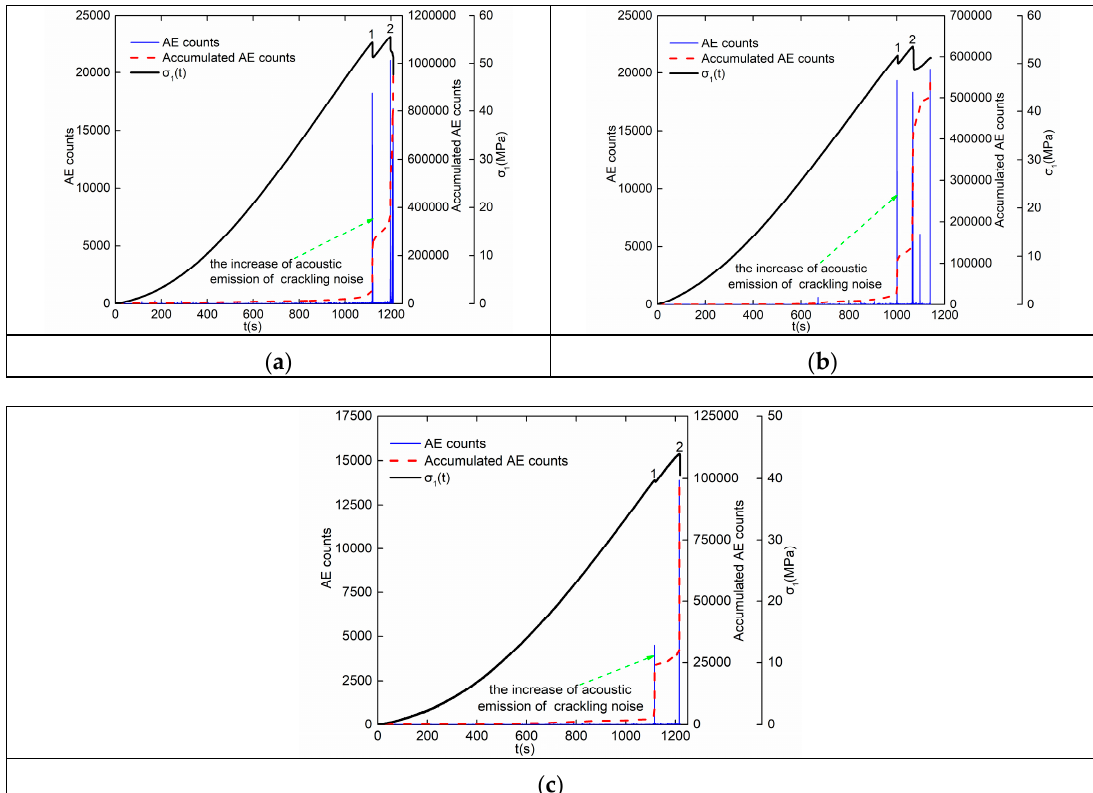
Figure 7. The time evolution of the AE counts, cumulative AE counts and axial stress: ( a ) B-30, ( b ) B-45, ( c ) B-60.